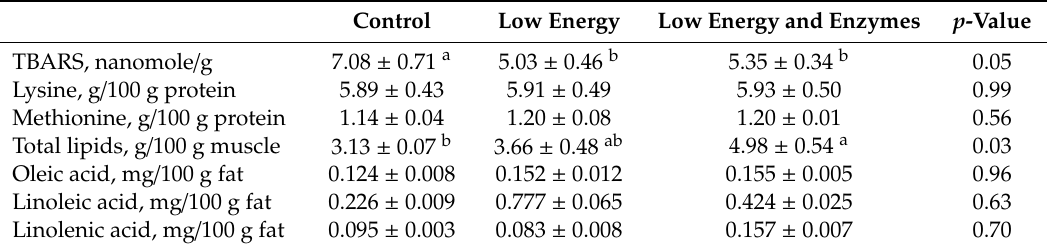
Table 5. E ff ect of NSP enzyme supplementation on lipid peroxidation, fatty acids, and amino acids in breast muscle of